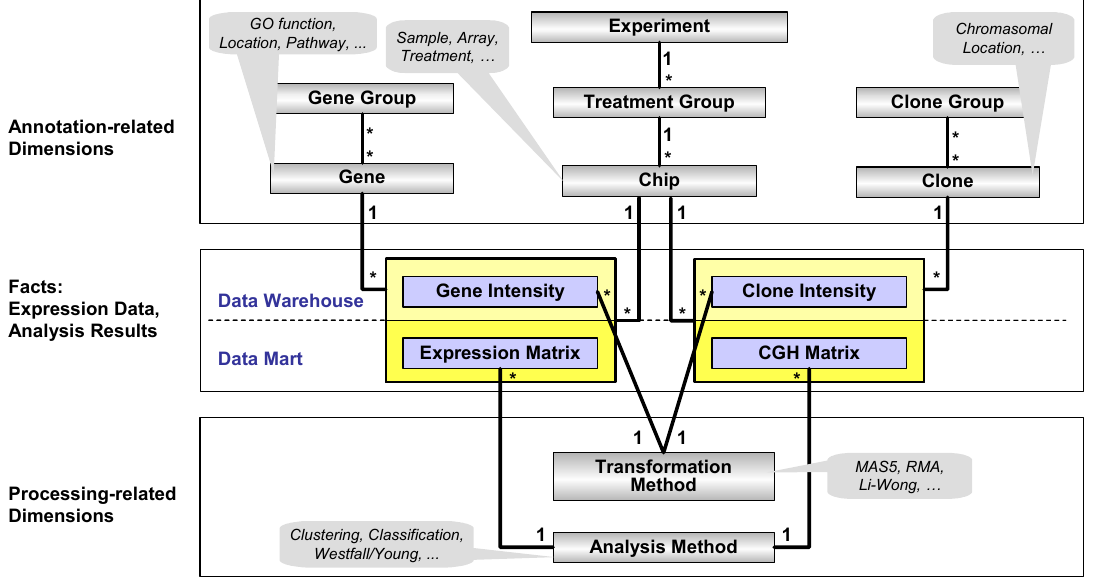
Figure 3: High-level data warehouse